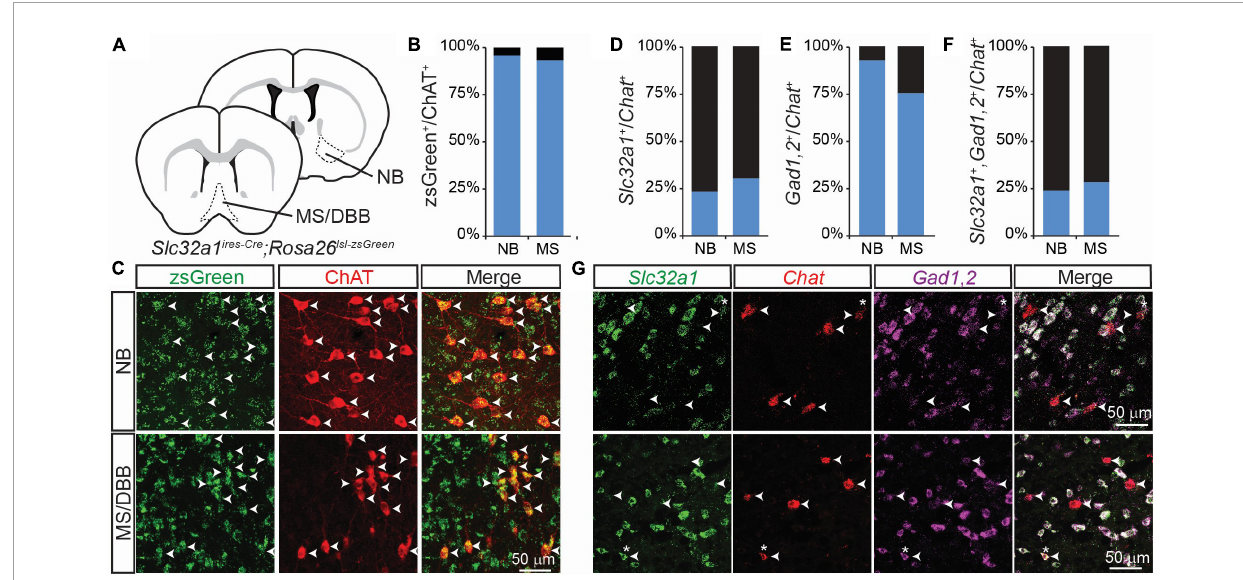
FIGURE1 Integrated genetic labeling shows higher co-expression of GABAergic markers in cholinergic cells than fluorescent in situ hybridization in adult mice. (A) Schematic showing the brain regions imaged for this study, including the nucleus basalis (NB), which provides the main cholinergic input to the cortex, and medial septum/diagonal band of broca (MS/DBB), which provides cholinergic input to the hippocampus. Genetic labeling of Slc32a1 expression is achieved by crossing Slc32a1 ires − Cre mice, which expresses Cre recombinase from the endogenous Slc32a1 locus, with Rosa26 lsl − zsGreen , which expresses the soma-localizing fluorophore zsGreen in a Cre-dependent fashion. (B,C) Quantification and example images of zsGreen-expressing neurons co-labeled with an immunostain for ChAT (598 zsGreen + /624 ChAT + NB neurons from n = 3 mice; 560 zsGreen + /601 ChAT + MS/DBB neurons from n = 3 mice. Data adapted from Saunders et al. (2015a). (D–F) Quantification of colocalization of FISH for Slc32a1 (D) , Gad1,2 (E) or both (F) with Chat , (49 Slc32a1 + /199 Chat + BF neurons from n = 5 mice and 54 Slc32a1 + /181 Chat + MS neurons from n = 4 mice; 159 Gad1,2 + /199 Chat + BF neurons from n = 5 mice and 86 Gad1,2 + /181 Chat + MS neurons from n = 4 mice; 48 co-positive/ Chat + 199 BF neurons from n = 5 mice and 52 co-positive/181 Chat + MS neurons from n = 4 mice). (G) Example images showing FISH for Slc32a1 (green), Chat (red ), Gad1 ,2 (Magenta), and the merged imaged. Arrow heads show the positions of Chat + neurons, and asterisks indicate Chat + ROIs with strong co-expression of Slc32a1 and Gad1,2